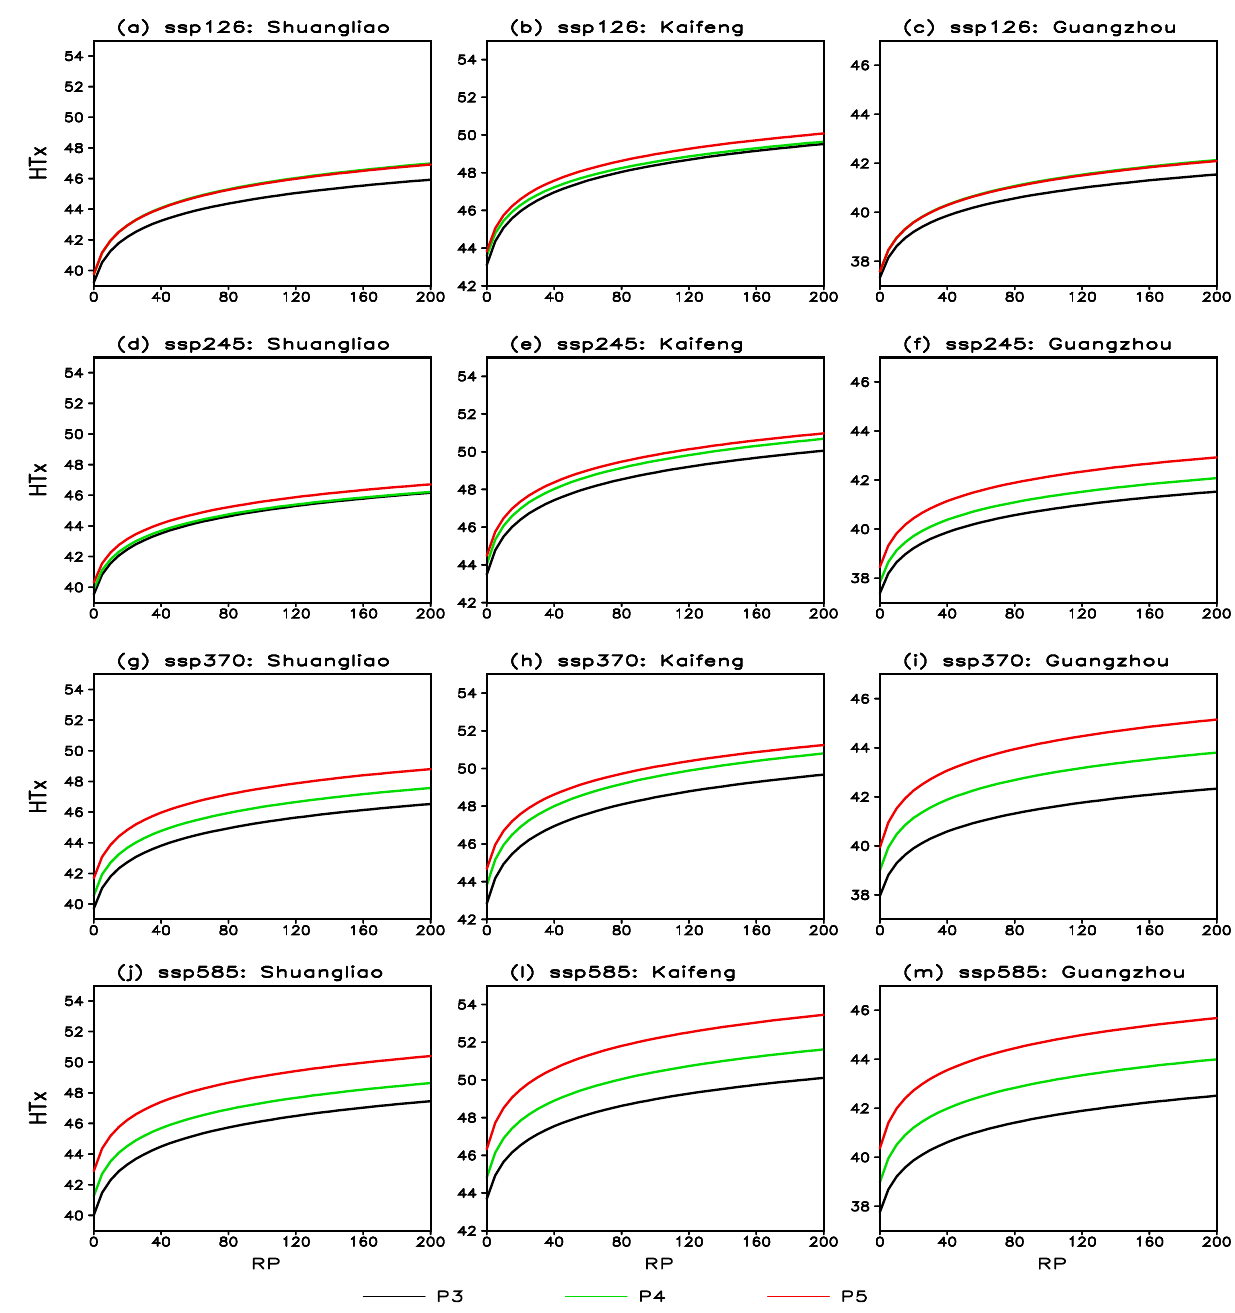
Fig. 6 Ensemble mean of HTx changes with RP derived from simulated samples under different scenarios from SSP1-2.6 to SSP5-8.5 for three selected stations (The black line is for P3, green for P4 and red for